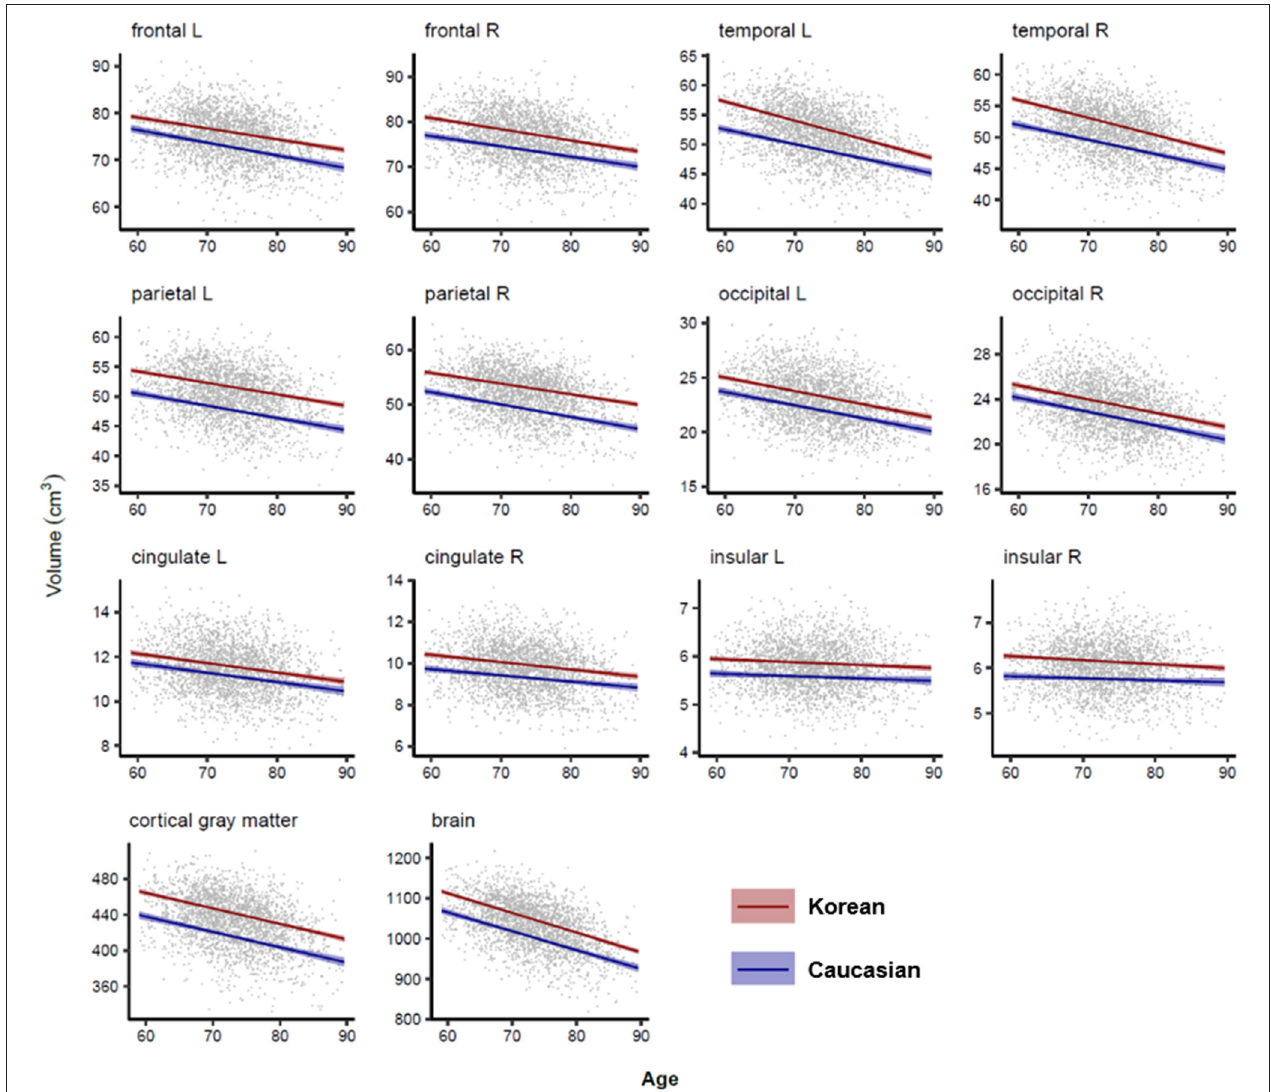
FIGURE 4 | Lobar volume changes with age in Caucasian and Korean elderly people. This figure illustrates ethnic contrast on age effect in each model predicting lobar volumes in a massive sample of cognitively normal people aged 59–89 years. Each line denotes mean volume with 95% confidence intervals in the colored